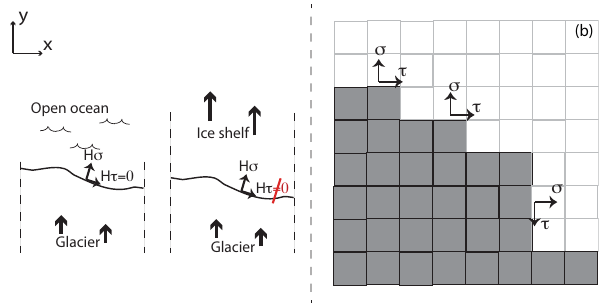
Figure B1. (a) Planform visualization of depth-integrated normal and shear stress along a vertical front or grounding line. In the case of the ice shelf, the stress balance must be solved within the glacier and ice shelf, and stresses along the grounding line de- pend on this solution. If these grounding-line stresses were imposed along the calving cliff, velocities in the glacier would be the same in both cases. (b) Schematic of representation of boundary stresses through parameters. Shaded cells represent computational domain, and white cells represent area where an ice shelf would be, were it included in the domain. Separate degrees of freedom describe nor- mal and shear stress at each cell